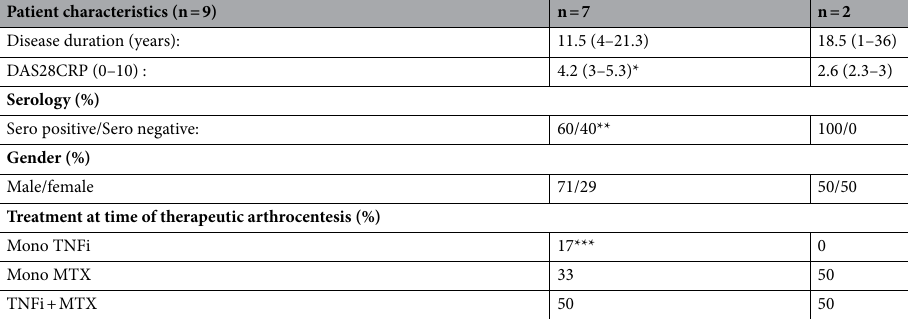
Table 2. Patient characteristics. Shown as donors who either were able to (n = 7) or failed to (n = 2) form sfRA-FLS cultures. Data are expressed as %. *Three patients had missing DAS28CRP data **Two patients had missing serology data ***One patient had missing treatment data. DAS28CRP, disease activity score 28 based on CRP; RA, rheumatoid